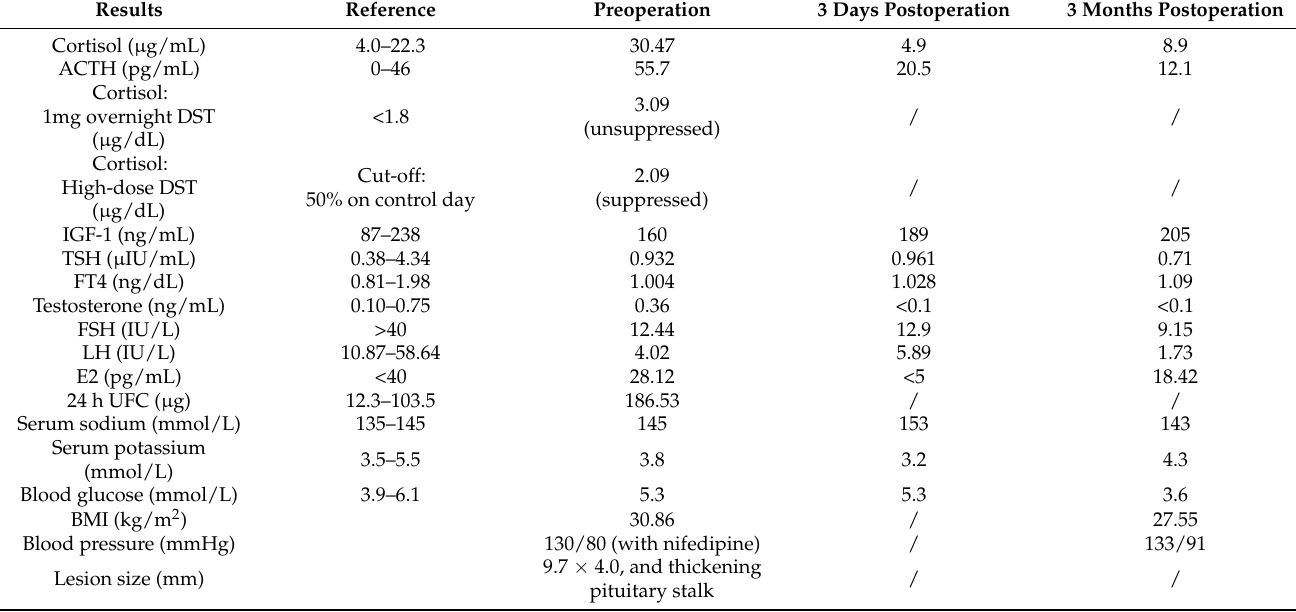
Table 1. Clinical characteristics of case 1